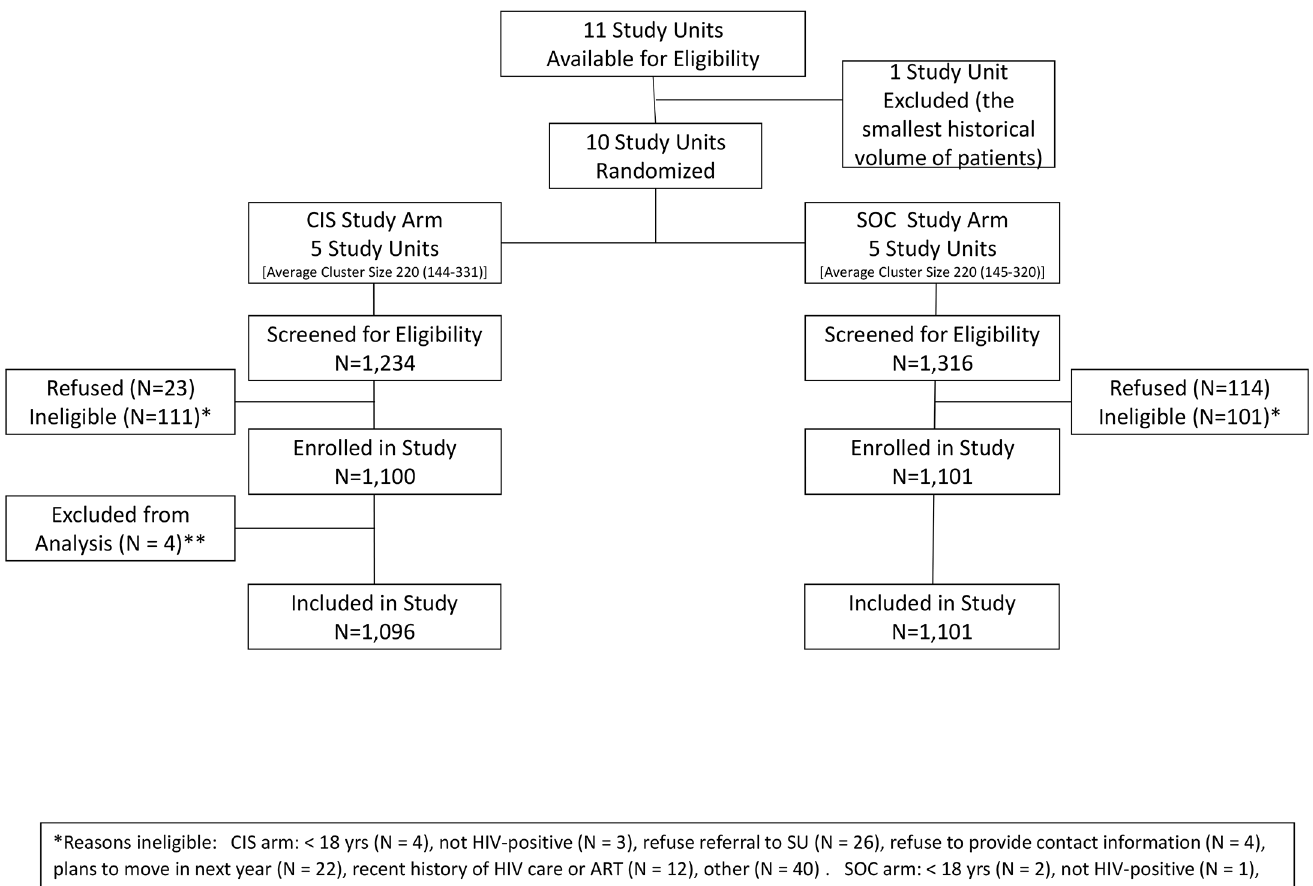
Fig 1. Flow diagram of study enrollment. ART, antiretroviral therapy; CIS, combination intervention strategy; SOC, standardof care; SU, study unit.